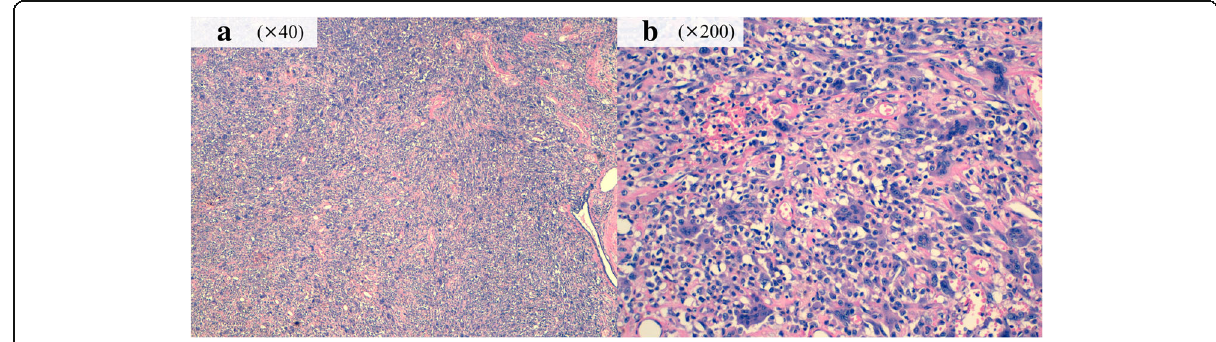
Fig. 3 Histology of the surgical specimen. The tumor was composed mainly of oval and spindle mononuclear histiocyte-like cells and multinucleated giant cells without malignant cells; hematoxylin and eosin stain, × 40 ( a ) and × 200 ( b